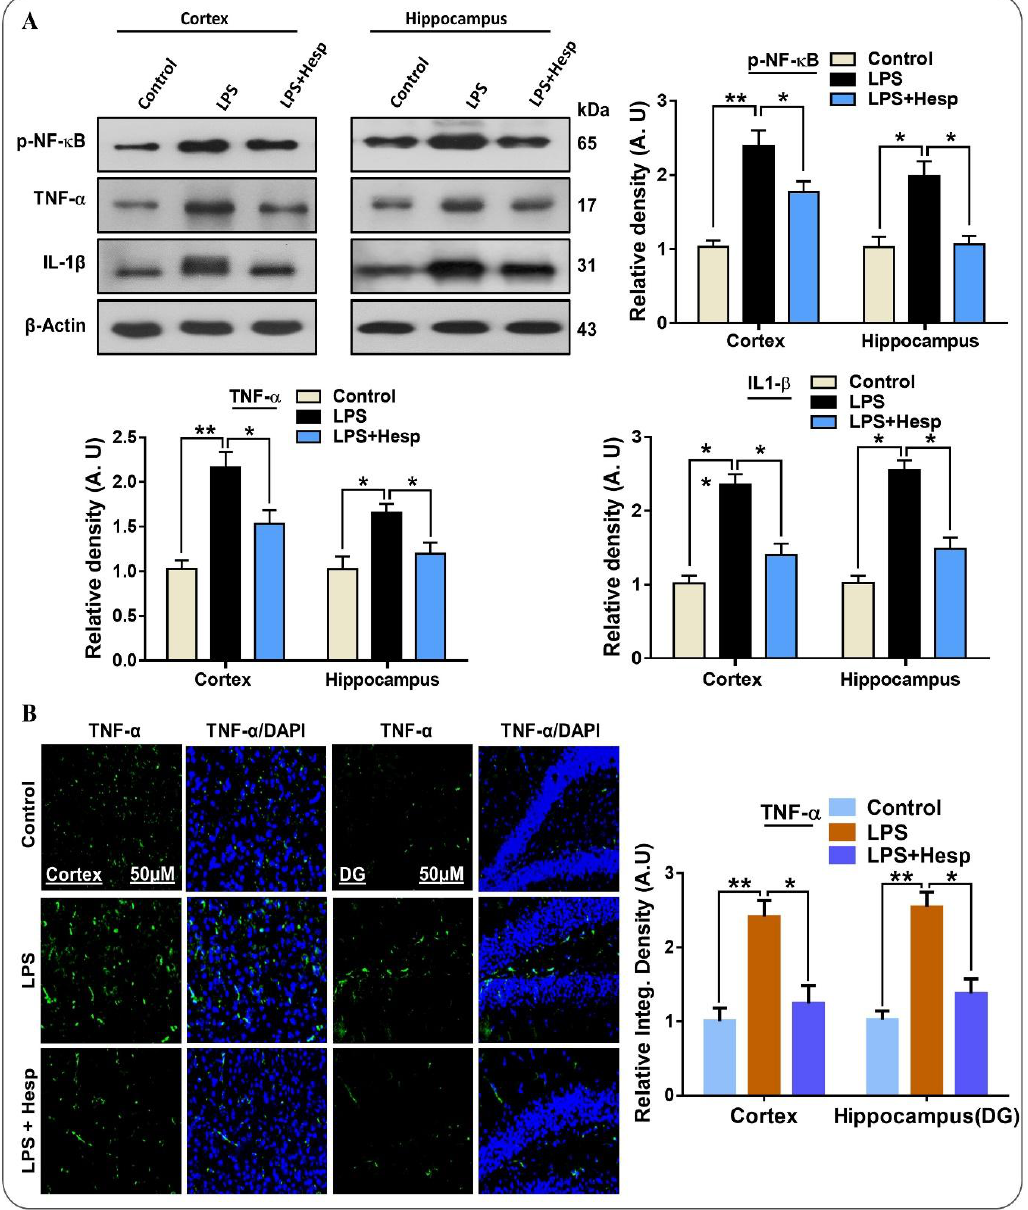
Figure 3. Hesperetin mitigates the expression of p-NF-κB and inflammatory cytokines in LPS-treated mouse brains and BV2 cells: ( A ) Western blot analysis of p-NF-κB, TNF-α, and IL-1β expression in the cortex and hippocampus of mice; ( B ) immunofluorescence analysis of TNF-α immunoreactivity in the cortex and DG region of the hippocampus. The data are presented as the mean ± SEM of 7–10 mice per group and are representative of three independent experiments, * p ≤ 0.05, ** p ≤ 0.01.